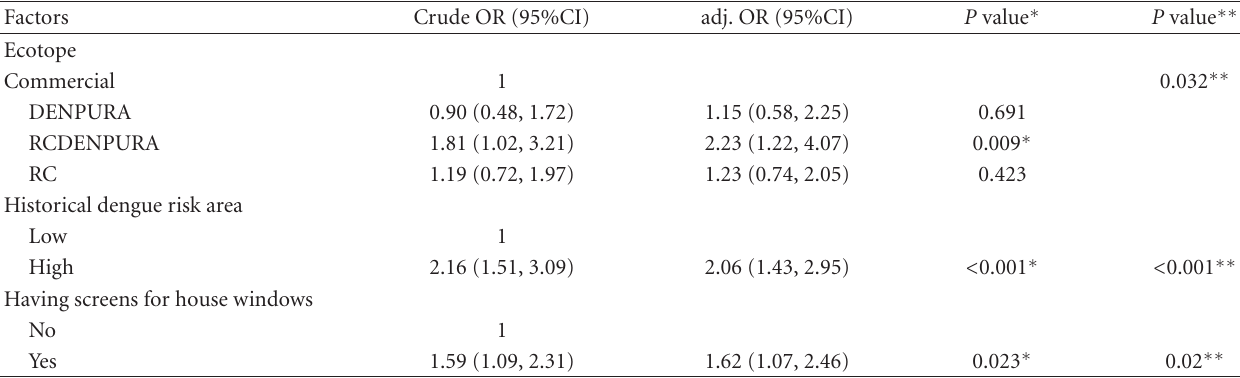
Table 2: Multivariate analysis of the association between ecological factors of households and dengue transmission.